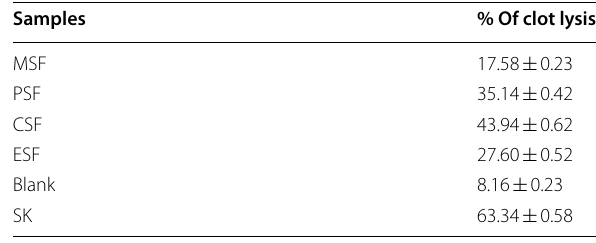
Table 5 Thrombolytic activity of the different fractions of C.